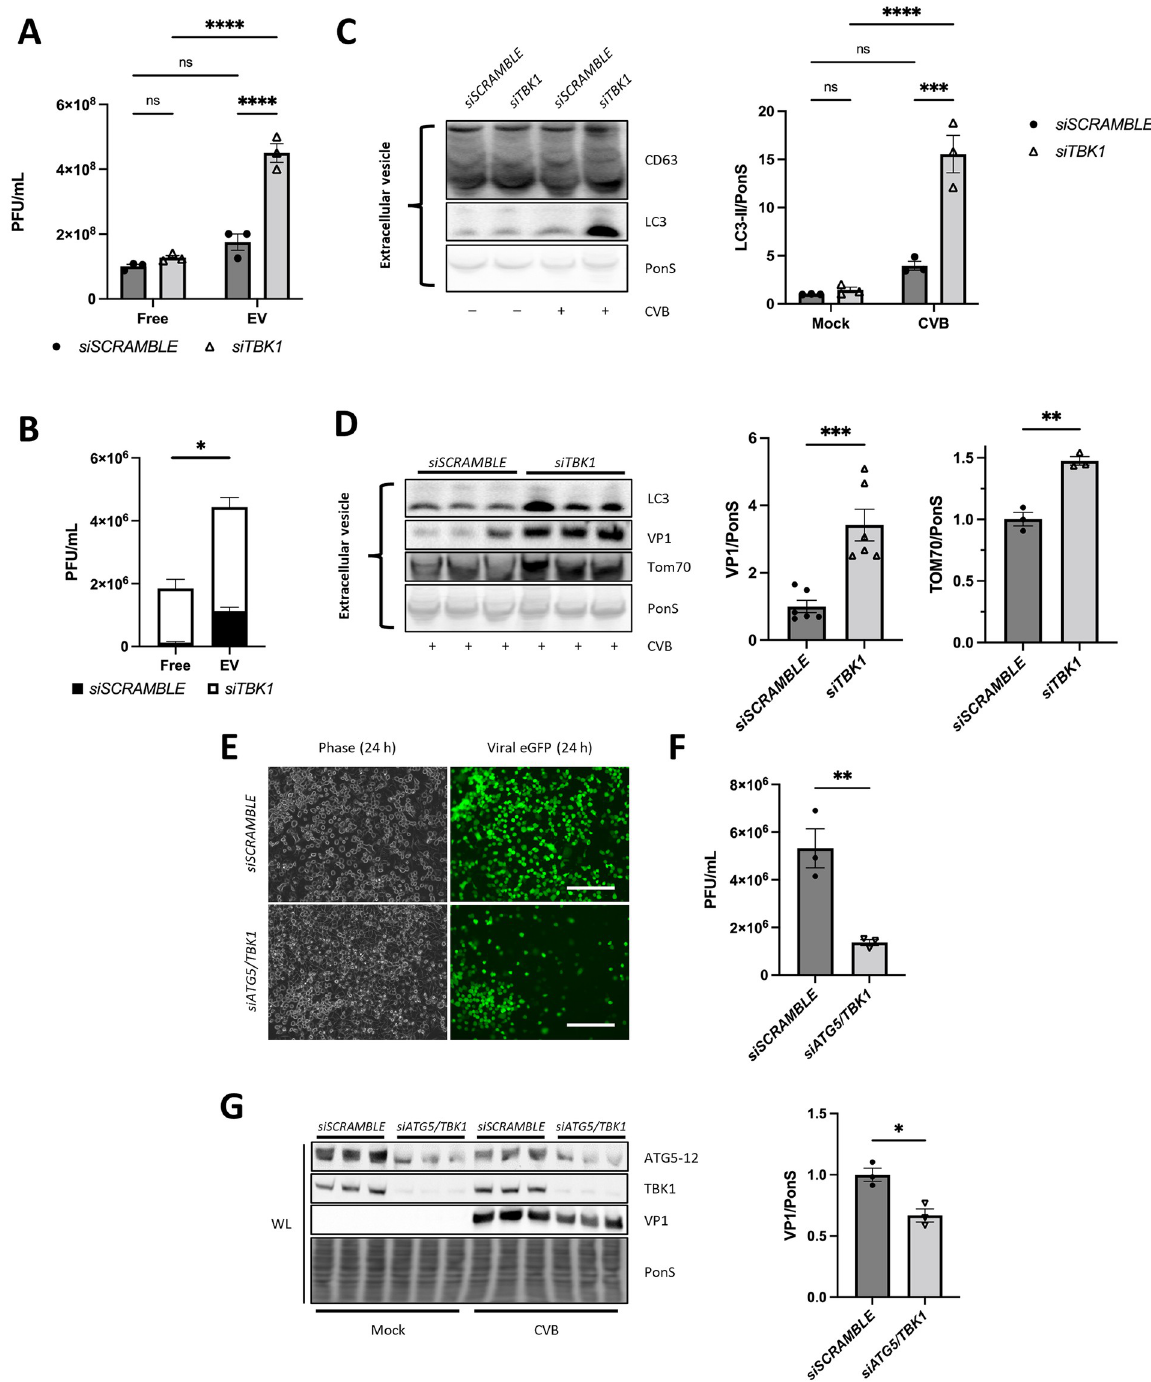
Fig 4. Loss of TBK1 increases the release of infectious extracellular vesicles. (A) HeLa cells were infected with eGFP-CVB at MOI 0.1. Plaque assays on free virus (free, isolated from Exoquick-TC supernatant) and EV virus (EV) isolated from cells 24 h p.i. ���� , p < 0.0001, two-way ANOVA; n = 3. (B) Ratio of free virus to EV virus plaque forming units shown in (A). � , p < 0.05, Student t test; n = 3. (C) Western blots of EV lysates isolated from mock-infected and CVB-infected cells at 24 h p.i. including densitometry. ��� , p < 0.001, two-way ANOVA; n = 3. (D) Western blots of EV lysates from CVB-infected cells at 24 h p.i. including densitometry. �� , p < 0.01, ��� , p < 0.001 two-way ANOVA; n = 3. (E) ATG5 and TBK1 were silenced in HeLa cells then infected at MOI 0.01 for 24 h. Fluorescence microscopy images of cells at 24 h p.i. Phase contrast images show similar cell density. Scale bars represent 100 μ m. (G) Extracellular viral titers of cell supernatants as measured by plaque assay. �� , p < 0.01, Student t test; n-3. (G) Western blots on WL from mock verus infected cells at 24 h p.i. � , p < 0.05, Student t test; n = 3. Data are representative of 3 experiments. WL = whole